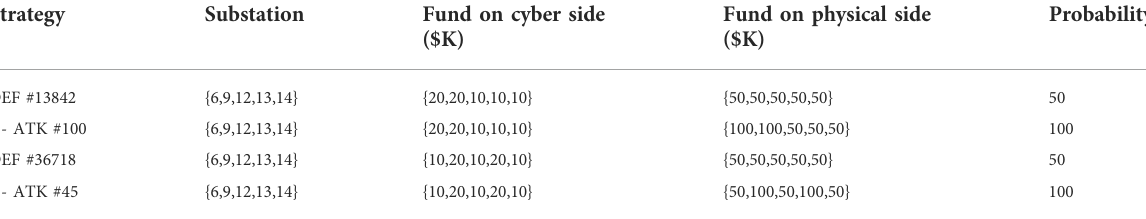
TABLE 9 Subgame perfect Nash equilibrium under speci fi c fund constraints.